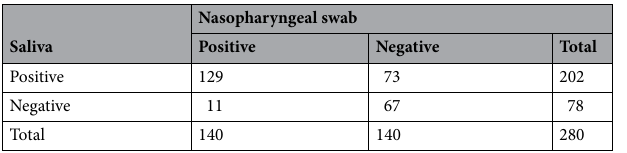
Table 1. Comparison of Real-Time RT-PCR results of paired saliva and Nasopharyngeal swab (n = 140) samples on day zero. P value < 0.001 by McNemar test.